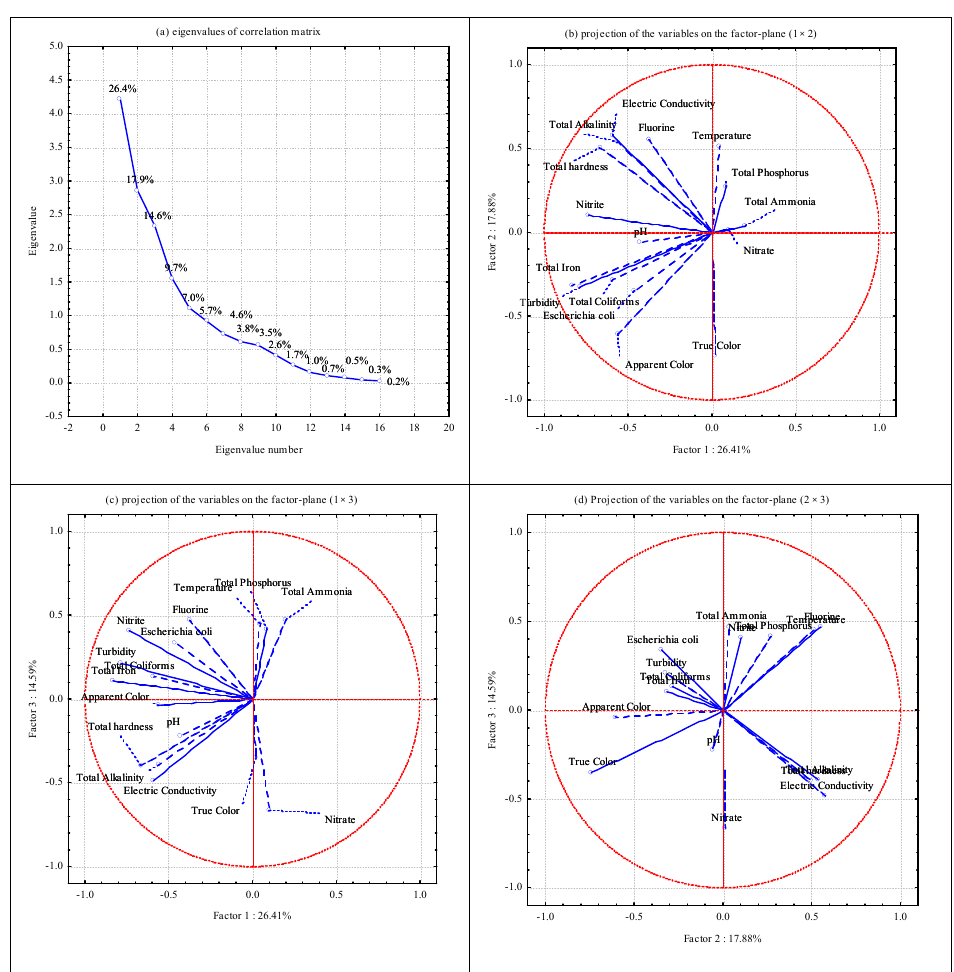
Figure 3. Percentage contribution of each principal component (PC), based on its eigenvalue ( a ); graphical representation of the relationship between the first and second ( b ), the first and third ( c ), and second and third ( d ) factor of the PC analysis, based on chemical, physical, specific chemical, and microbiological variables of